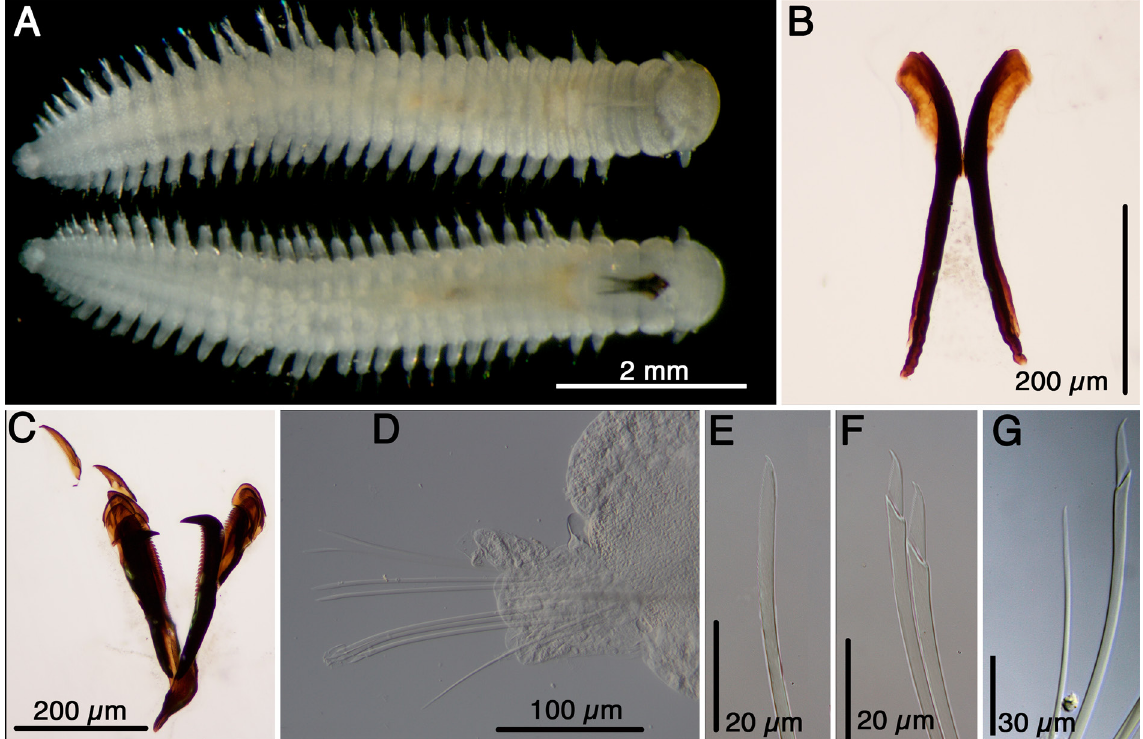
Fig. 3. Ophryotrocha cf. akessoni Blake, 1985. A . Dorsal and ventral views of live specimen (SIO-BIC A14105). B . Mandibles (SIO-BIC A14107). C . Maxillae (SIO-BIC A14107). D . Parapodium (SIO-BIC A14105). E . Simple supra-acicular chaetae (SIO-BIC A14105 ). F . Compound sub-acicular chaetae (SIO-BIC A14105 ). G . Simple sub-acicular chaeta (SIO-BIC A14106